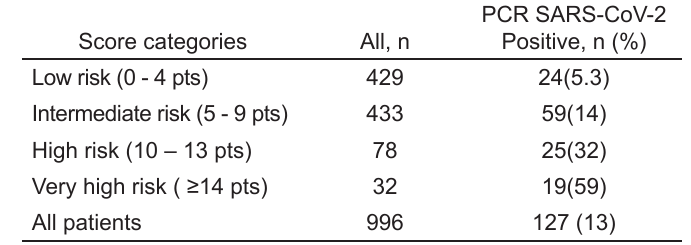
Table 5. PCR COVID-19 positivity by score category.